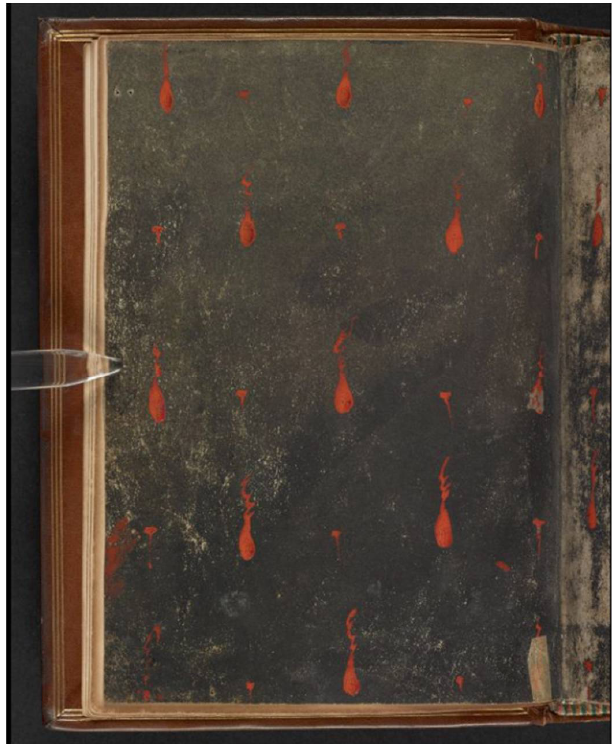
Figure 1. MS Egerton 1821, an 18 × 12 cm large multisensory compendium of devotional practices from the late 15th or early 16th century. It opens with several black pages with big drops of blood. MS Egerton 1821, fol. 1v., British Library, London.